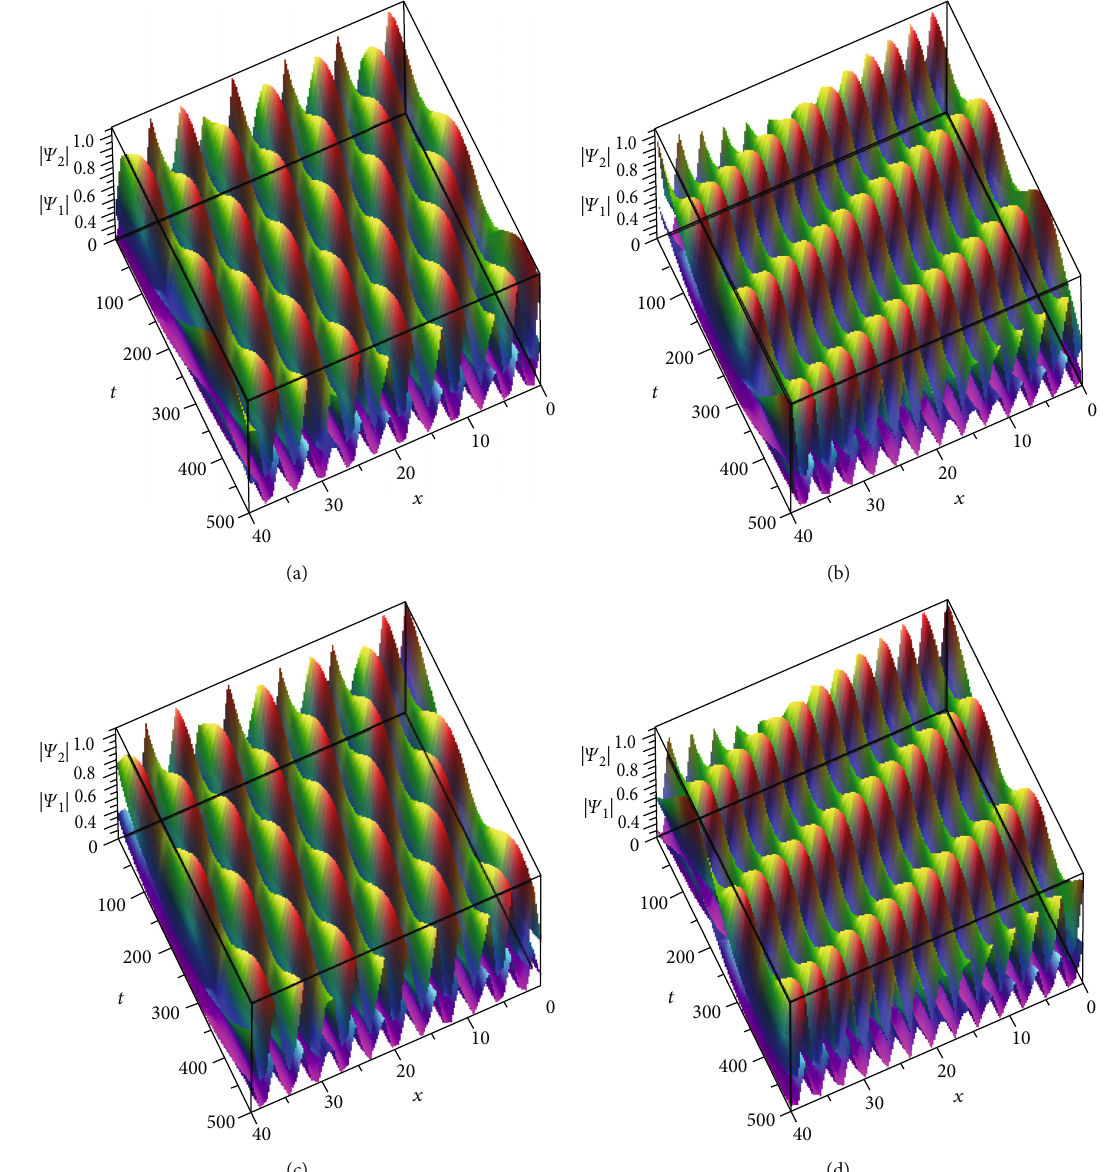
x , t Þj and j Ψ x , t Þj as in Equation (54) and Equation (55), respectively, for BFD parameter (a) 1 ð 2 ð = r = 0 : 2 , s = − 0 : 3 , and θ = 1 1 1 0 1